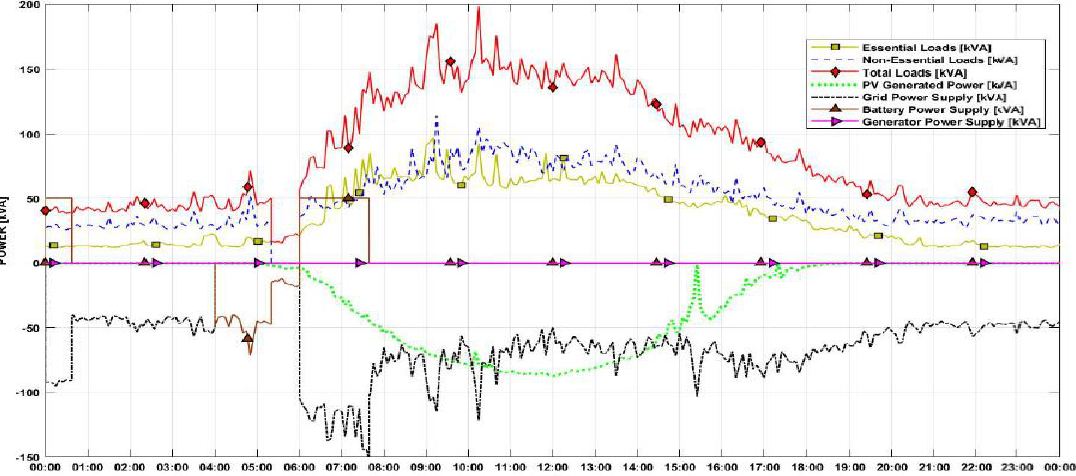
Figure 17. Performance of 150 kWh BESS during a 2-h power cut. Figure 16. The behavior of MCAST micro-grid integrated with a 150 kWh BESS and 150 kVA diesel generator during a 2- h power cut.